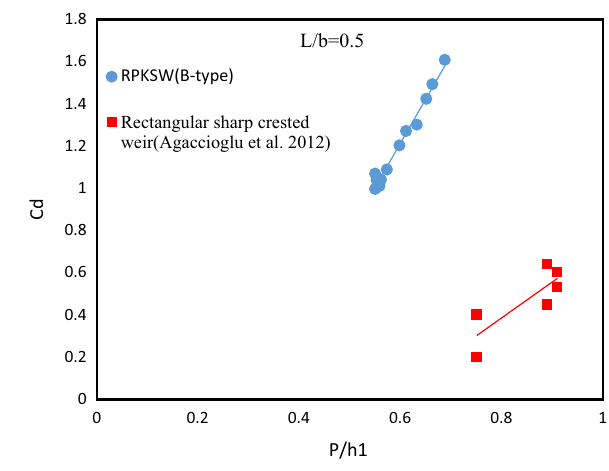
Fig. 9 Variations of discharge coefficient of RPKSW versus Froude number with L = 25 cm